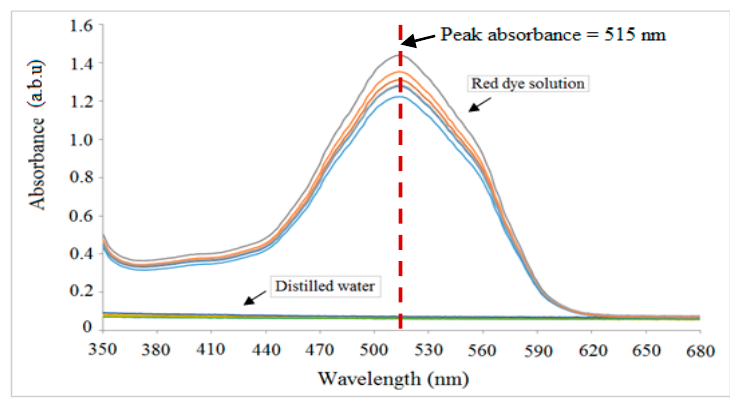
Figure 12. Spectrometry analysis for the highest and lowest concentration solution .